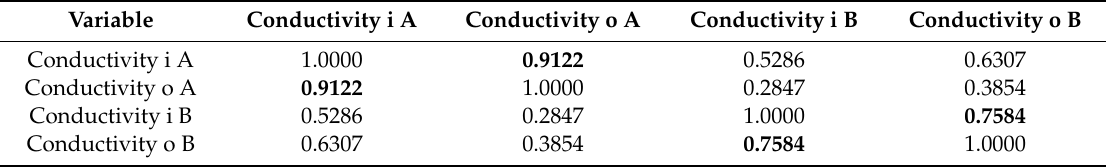
Table 12. Correlation matrix for water conductivity. Sample size n =